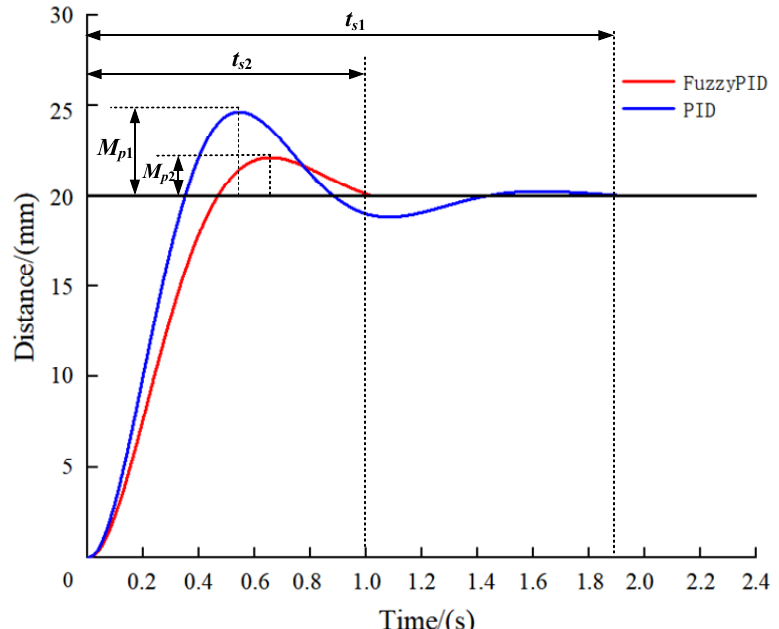
Figure 10. The step response curve of the side-shift stubble avoidance system. Note: t s1 and t s2 are the regulation time required for the PID and Fuzzy PID response curves to reach steady state, respectively, s; Mp 1 and Mp 2 are the maximum overshoot of PID and Fuzzy PID, respectively, %; PID is the proportion integral differential.